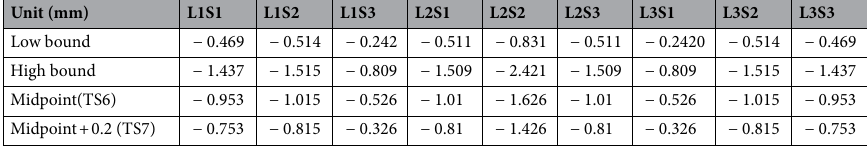
Table 5. The target deflection sets for 40 voxel beam.